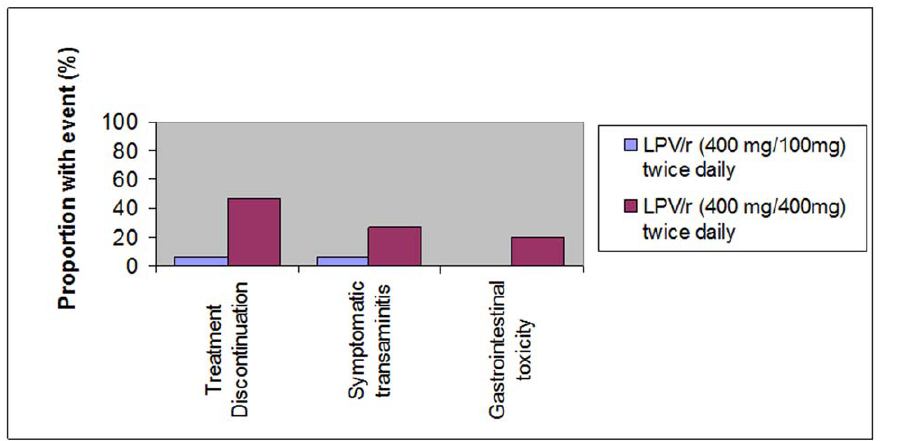
Figure 1. Adverse events among patients who received standard dose and ‘‘super-boosted’’ lopinavir/ritonavir dosing during concomitant treatment for